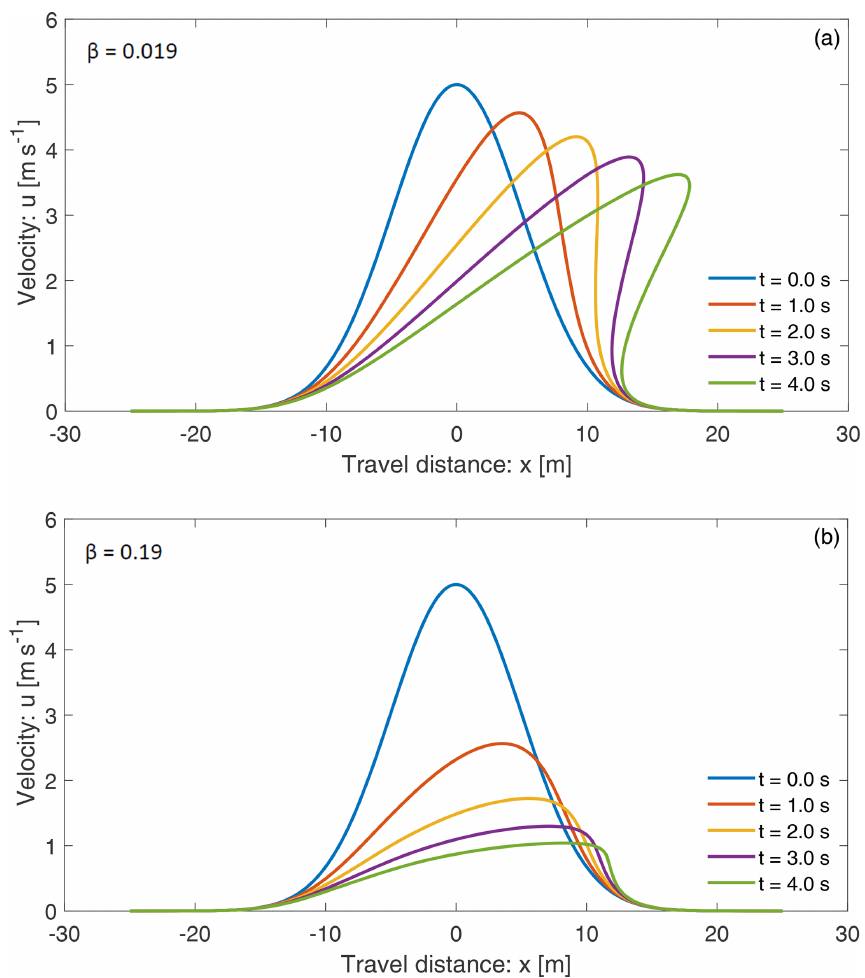
Figure 15. The control of the viscous drag on the dynamics of the landslide. The net driving force is set to zero, i.e., α = 0. The viscous drag has been amplified by 1 and 2 orders of magnitudes in panels (a) and (b) , showing dampened or complete prevention of shock formation and wave breaking,